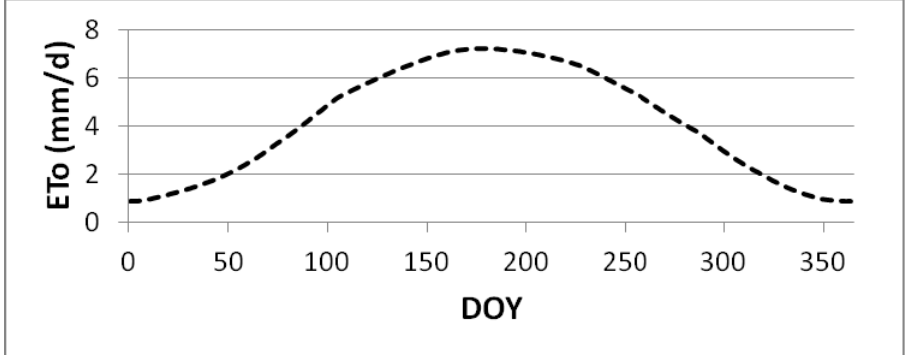
Figure 3. Historical average daily reference evapotranspiration (ETo) for study area, exemplified by data from the CIMIS Five Points station at UC-WSREC. Note seasonality effect, with higher values in